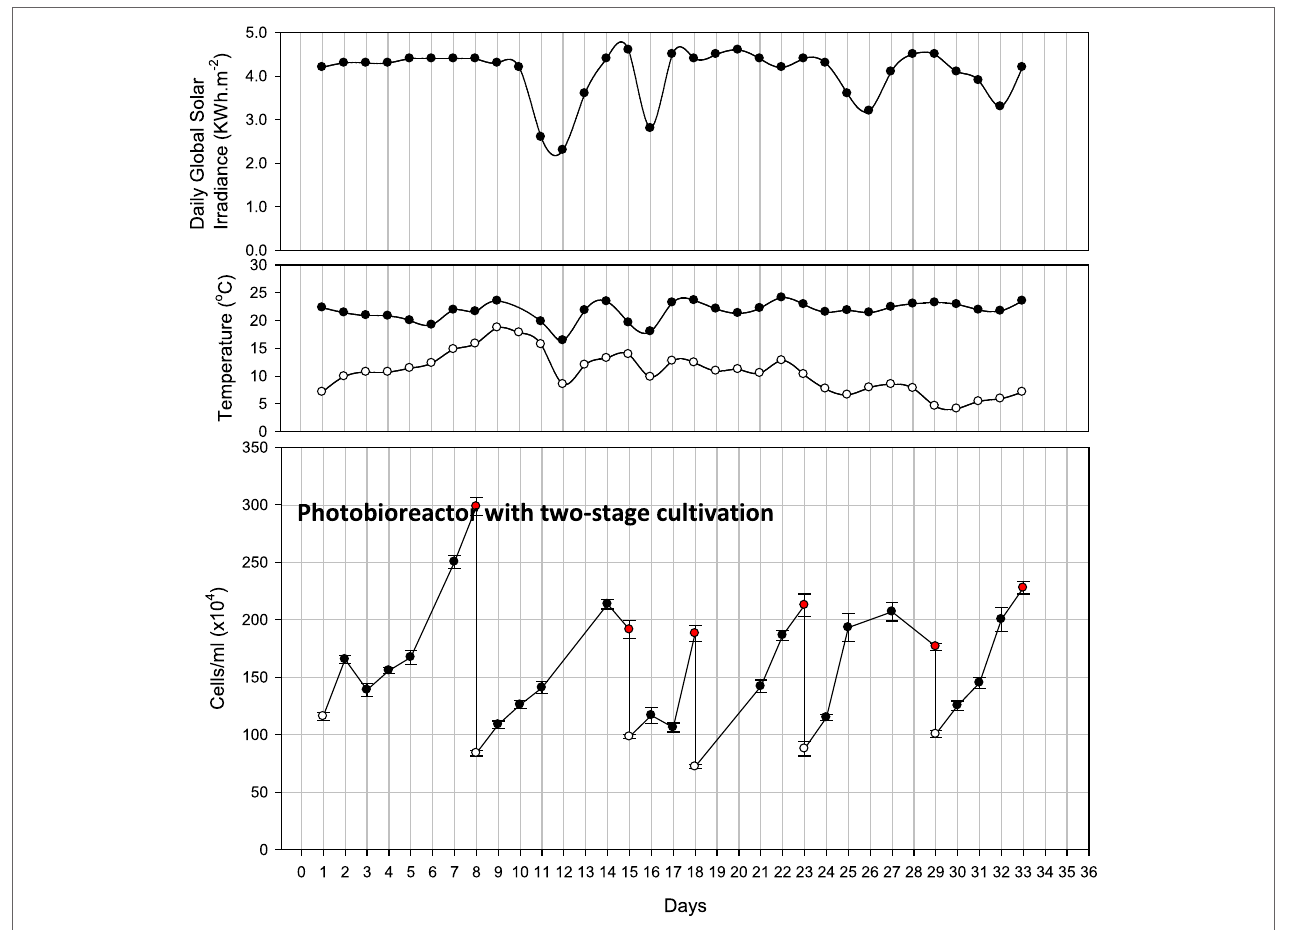
FigUre 5 | Observations of closed photobioreactor for two-stage cultivation for 35 days . Also shown is daily global solar irradiance, as well as minimum and maximum air temperature recorded for the respective day. White and red dots represent the start and finish of each